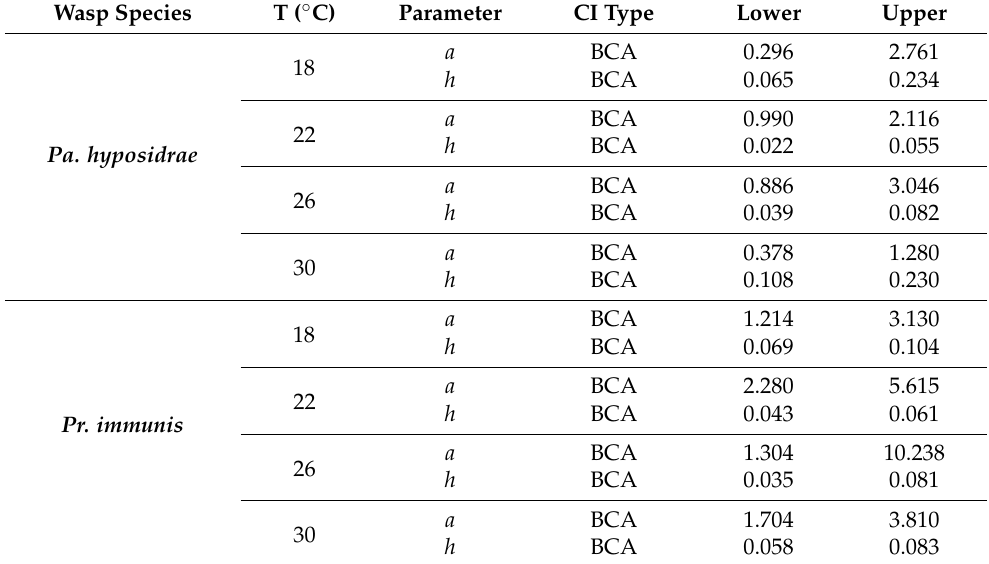
Table 3. Effects of temperature on functional response parameters of Pa. hyposidrae and Pr. immunis towards E. grisescens based on bootstrapped model.